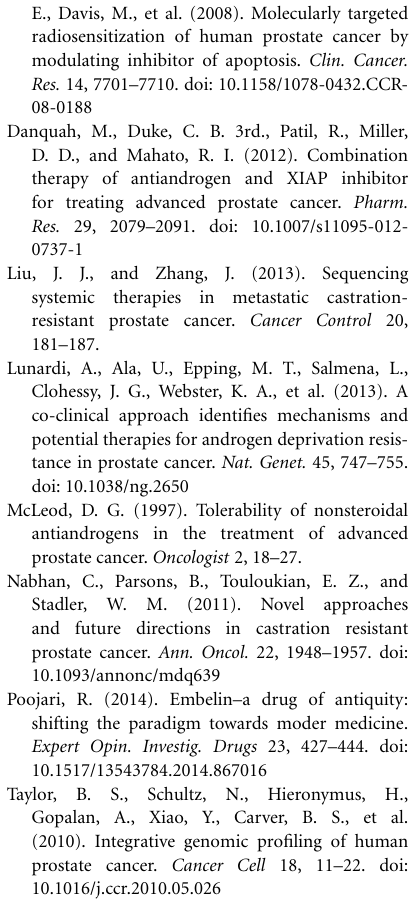
(10 mg/kg) and Dutasteride (2 mg/kg) oral dose 2 days per week for four